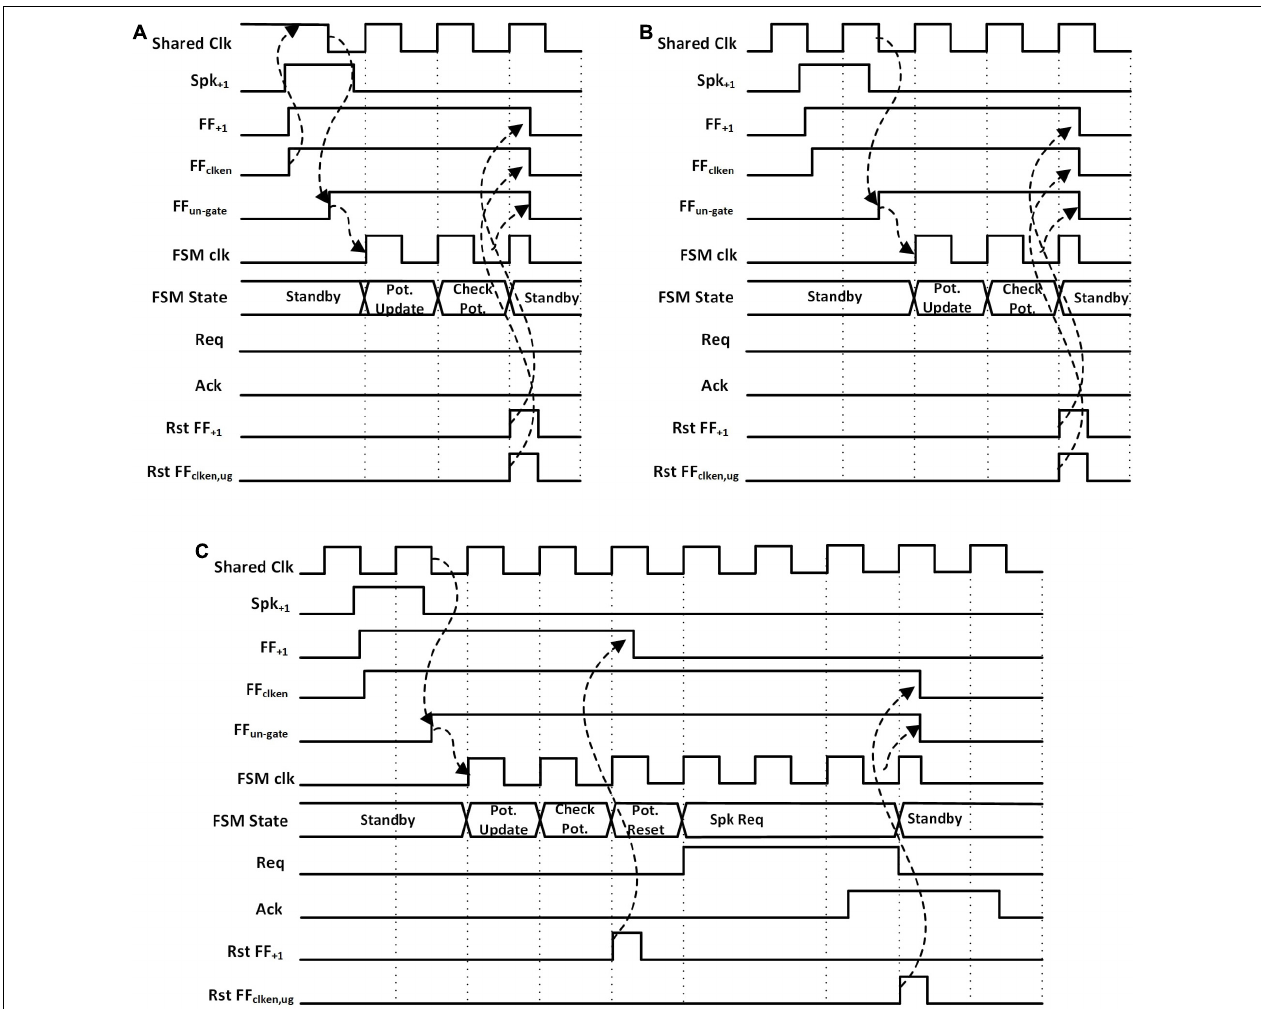
FIGURE 3 | Waveforms for a hidden neuron FSM when (A) potential is less than the threshold and shared clock was disabled, (B) potential is less than the threshold and shared clock is running (assume other neurons in the same neuron block are active), (C) potential is greater than the threshold and shared clock is